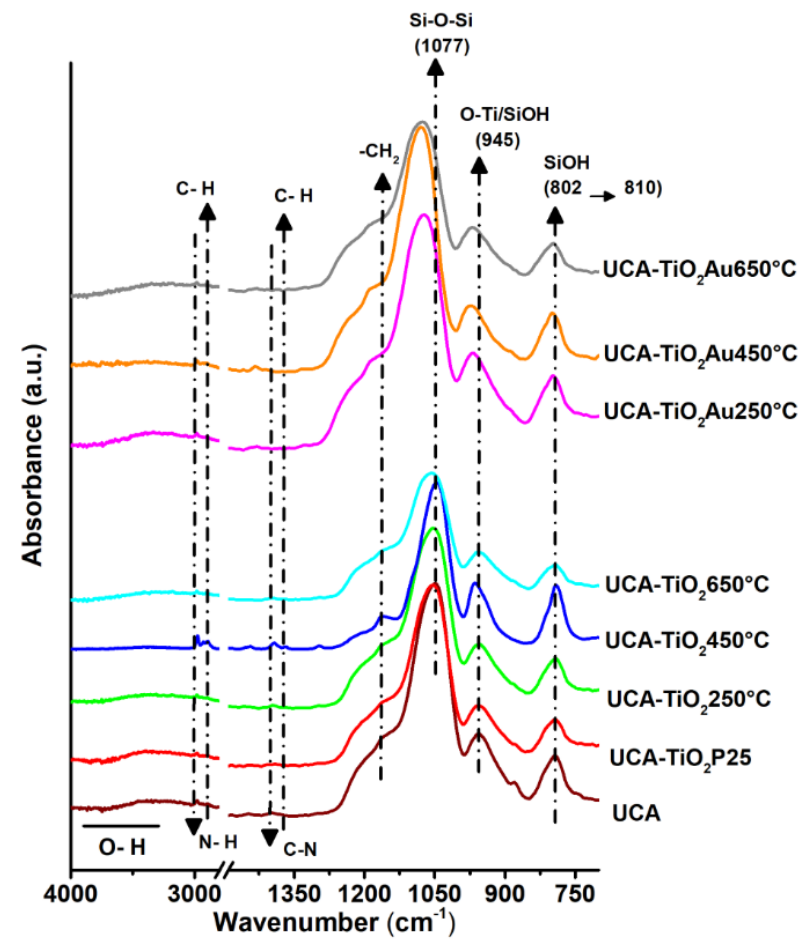
Figure 2. FTIR spectra of the synthesized UCA–TiO 2 nanocomposites under study.